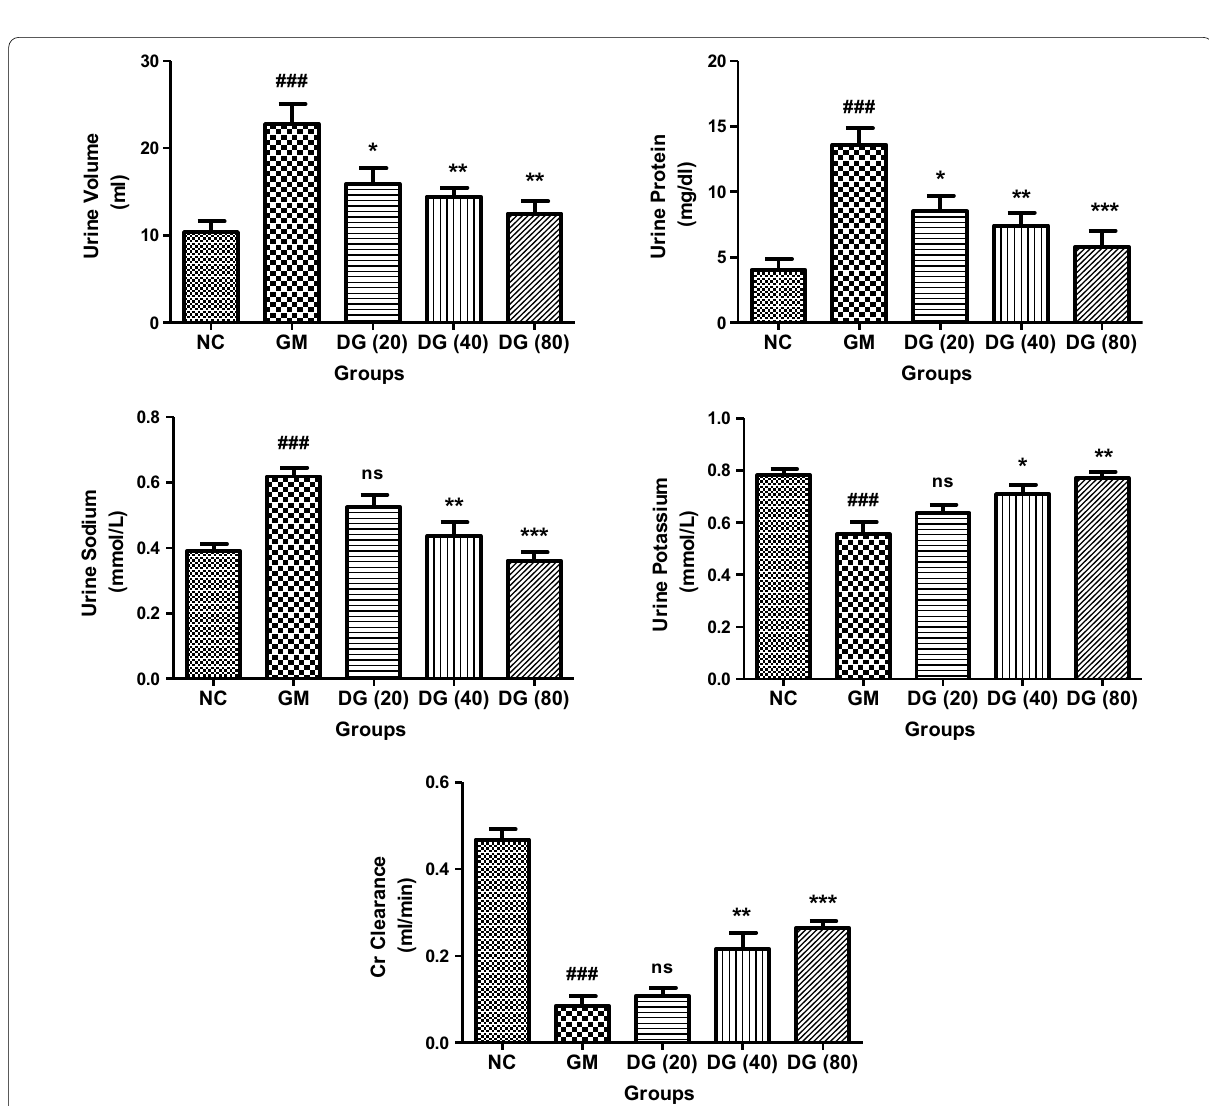
Fig. 4 Effect of DG on urine volume, urine Protein, urine Sodium, urine Potassium and creatinine clearance in GM induced renal damage in rats. Results are expressed as Mean SEM (n 6). ### p < 0.001 as compared to NC rats and * p < 0.05, ** p < 0.01, *** p < 0.001 compared to GM ± =